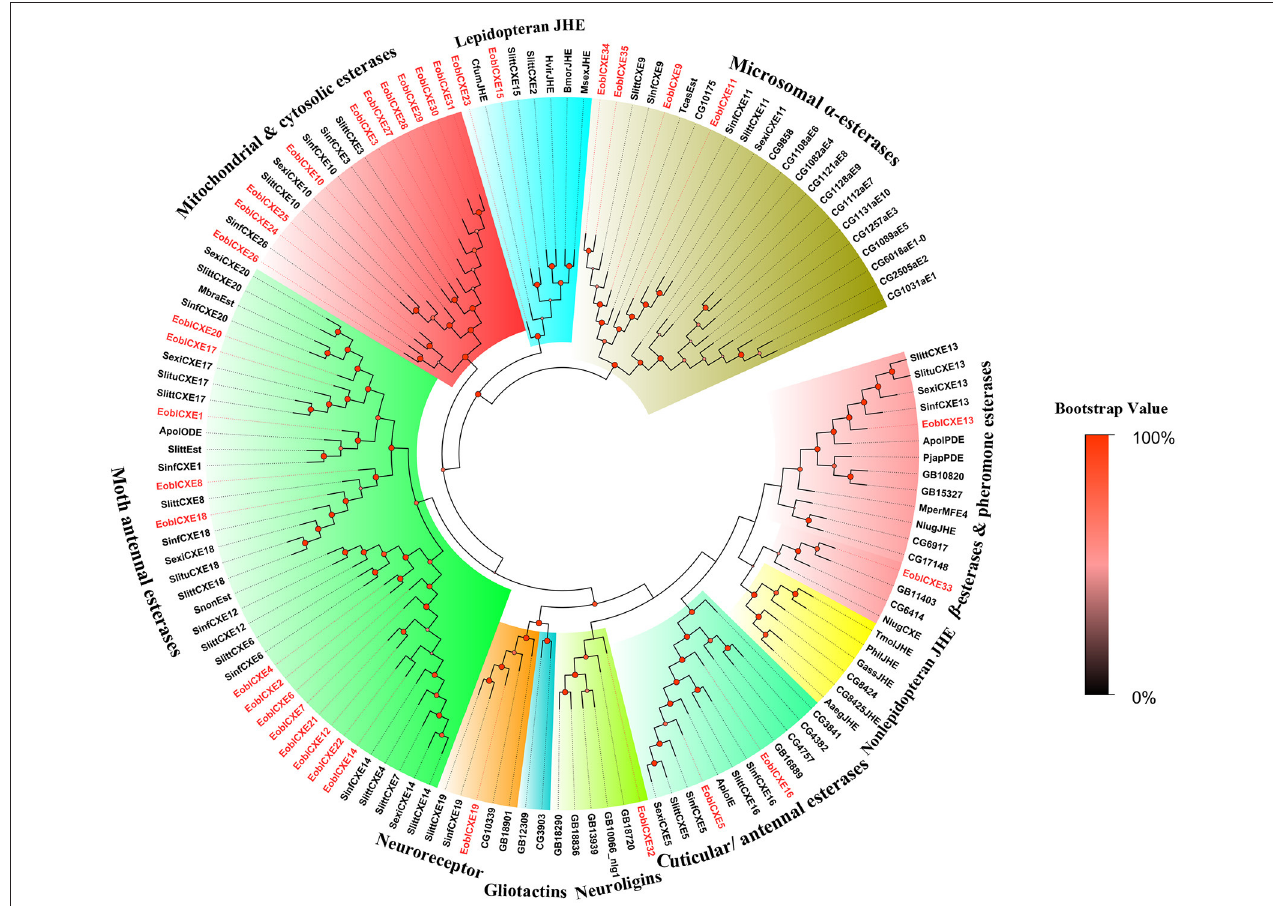
FIGURE 1 | Phylogenetic tree of insect carboxylesterases (CXEs). The tree was constructed with MEGA 6.0 using the neighbor-joining method. The values at the nodes are the results of bootstrapping with 1,000 replicates. EoblCXEs are shown in red. The accession numbers are given in Table S1 and alignment document was included in Supplementary